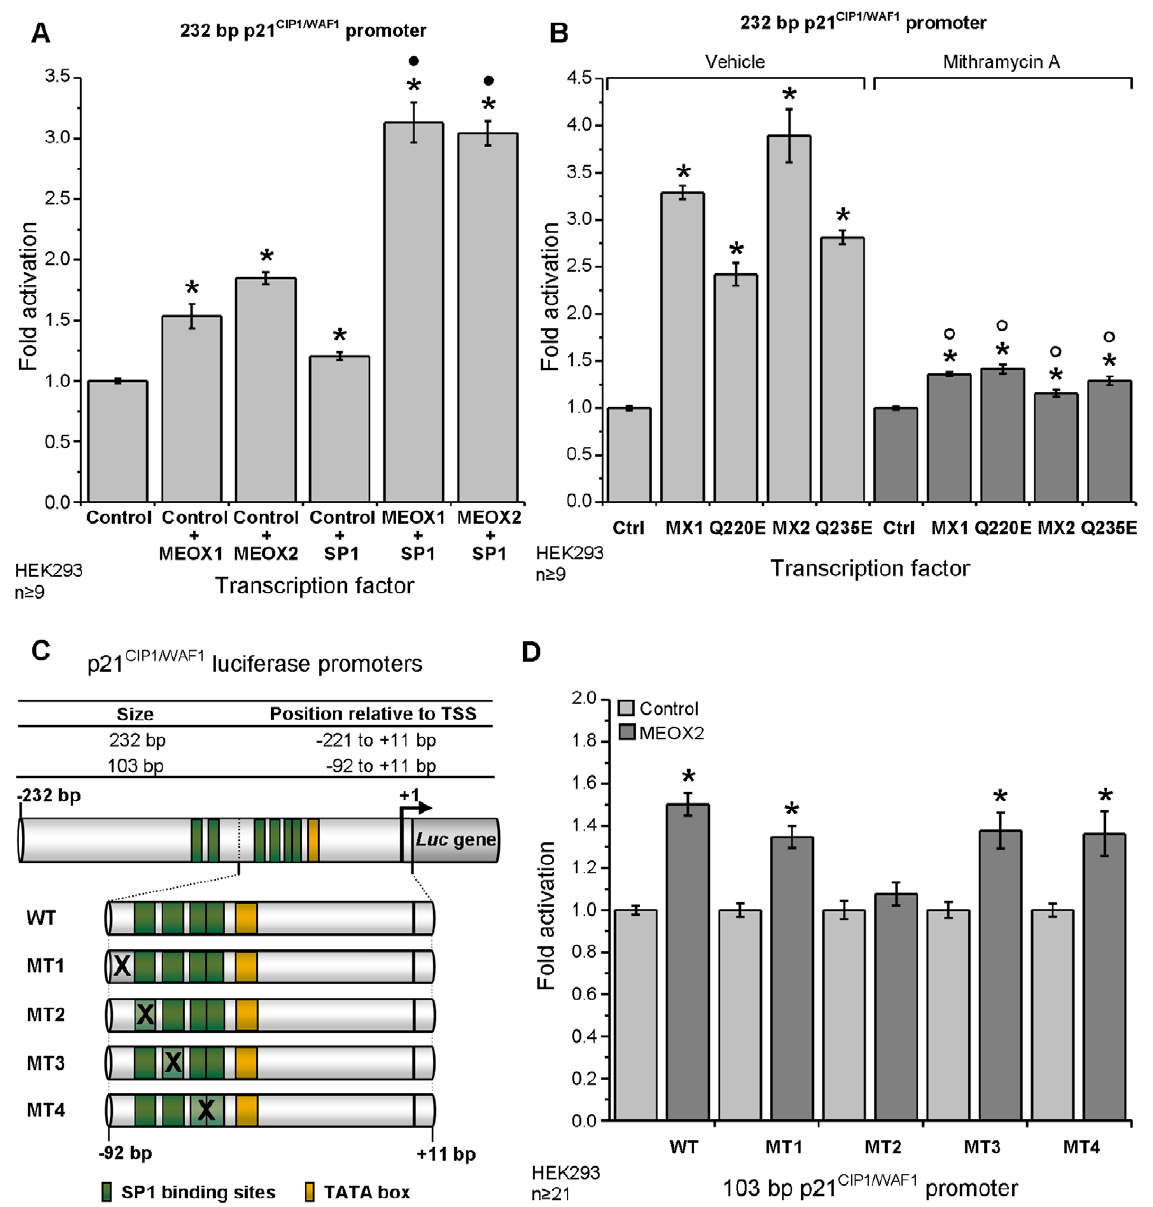
Figure 7. MEOX1 and MEOX2 activation of the p21 CIP1/WAF1 promoter is dependent on SP1 function. A) Co-transfection of SP1 enhanced the activation of the 232 bp p21 CIP1/WAF1 promoter by both MEOX1 and MEOX2. B) Treatment of cells with mithramyin A but not vehicle (methanol) for 24 hours blocked MEOX1 and MEOX2 mediated activation of the reporter gene from the 232 bp p21 CIP1/WAF1 promoter. C) Schematic diagram of the human 103 bp p21 CIP1/WAF1 promoter luciferase constructs used in this paper. D) Activation of the luciferase reporter gene from the 103 bp p21 CIP1/WAF1 promoter by MEOX2 was abolished through mutation of the most upstream SP1 site. WT = Wild-type promoter, MT = mutant promoters. * Indicates a statistically significant change (p , 0.05), when compared to the empty vector control. N Indicates a statistically significant difference (p , 0.05) between MEOX + Control and MEOX + SP1. # Indicates a statistically significant difference (p , 0.05) between vehicle and mithramycin A the co-ordinated up-regulation of both p21 CIP1/WAF1 and p16 INK4a are required for the induction of the cellular senescence program in HUVECs. To our knowledge, the MEOX proteins are the second instance of homeodomain transcription factors capable of inducing senescence. Ectopic expression of VentX, a transactivator of p16 INK4a , has recently been shown to cause senescence in cancer cells [46]. Corresponding to our results, these authors show that both p21 CIP1/WAF1 and p16 INK4a are involved in permanent cell cycle arrest.